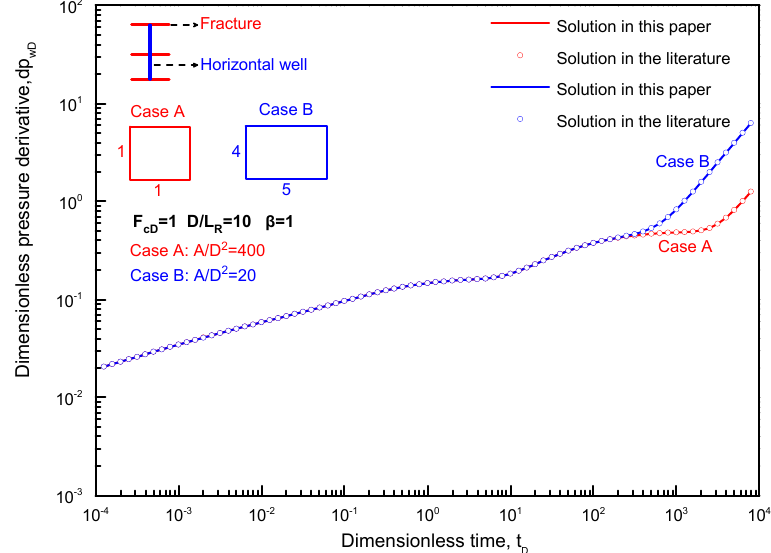
Figure 5. Comparison of pressure derivative for a horizontal well with three vertical fractures with the results of previous literature [8].